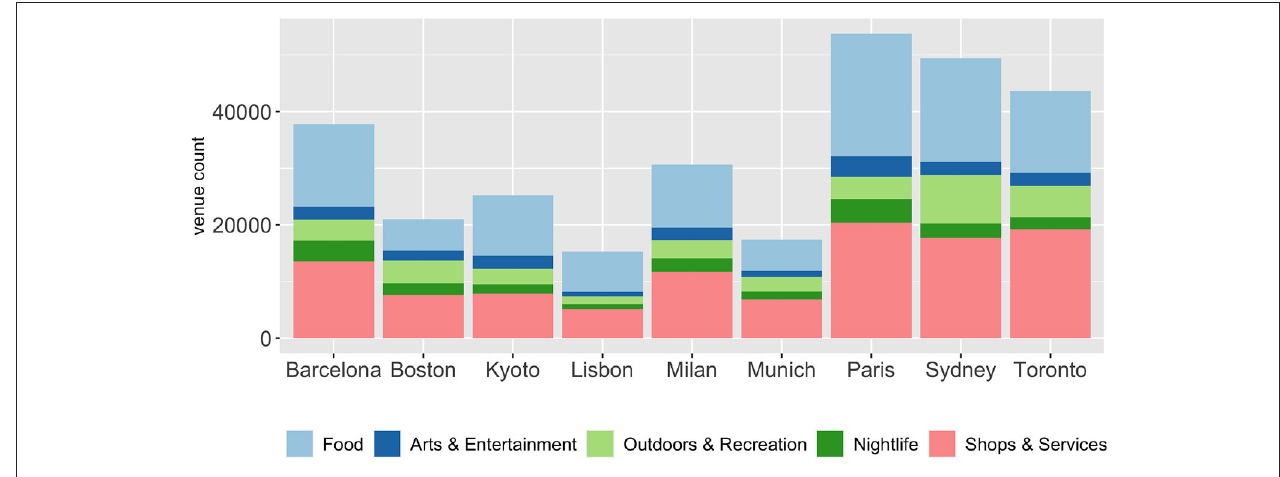
FIGURE 2 | Venue category distribution for a subset of